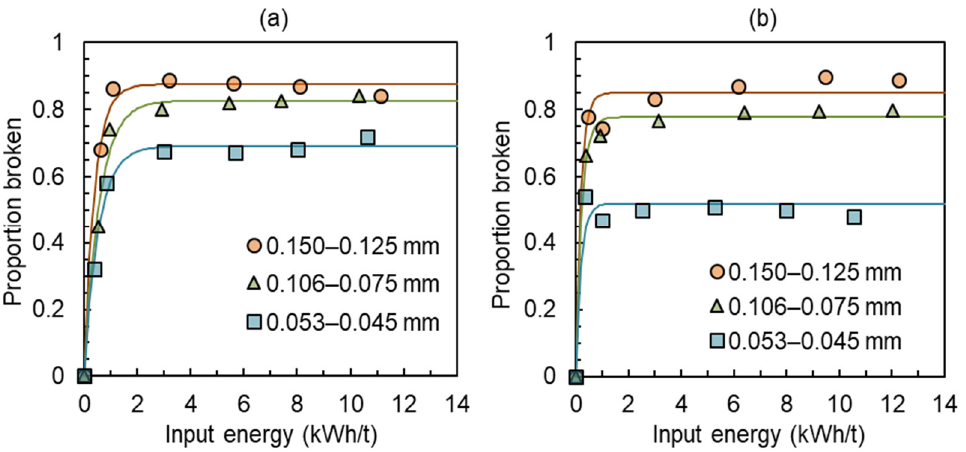
Figure 7. Proportion broken out of the original size for ( a ) Brucutu and ( b ) Carajás samples for different specific energies and feed particle sizes.